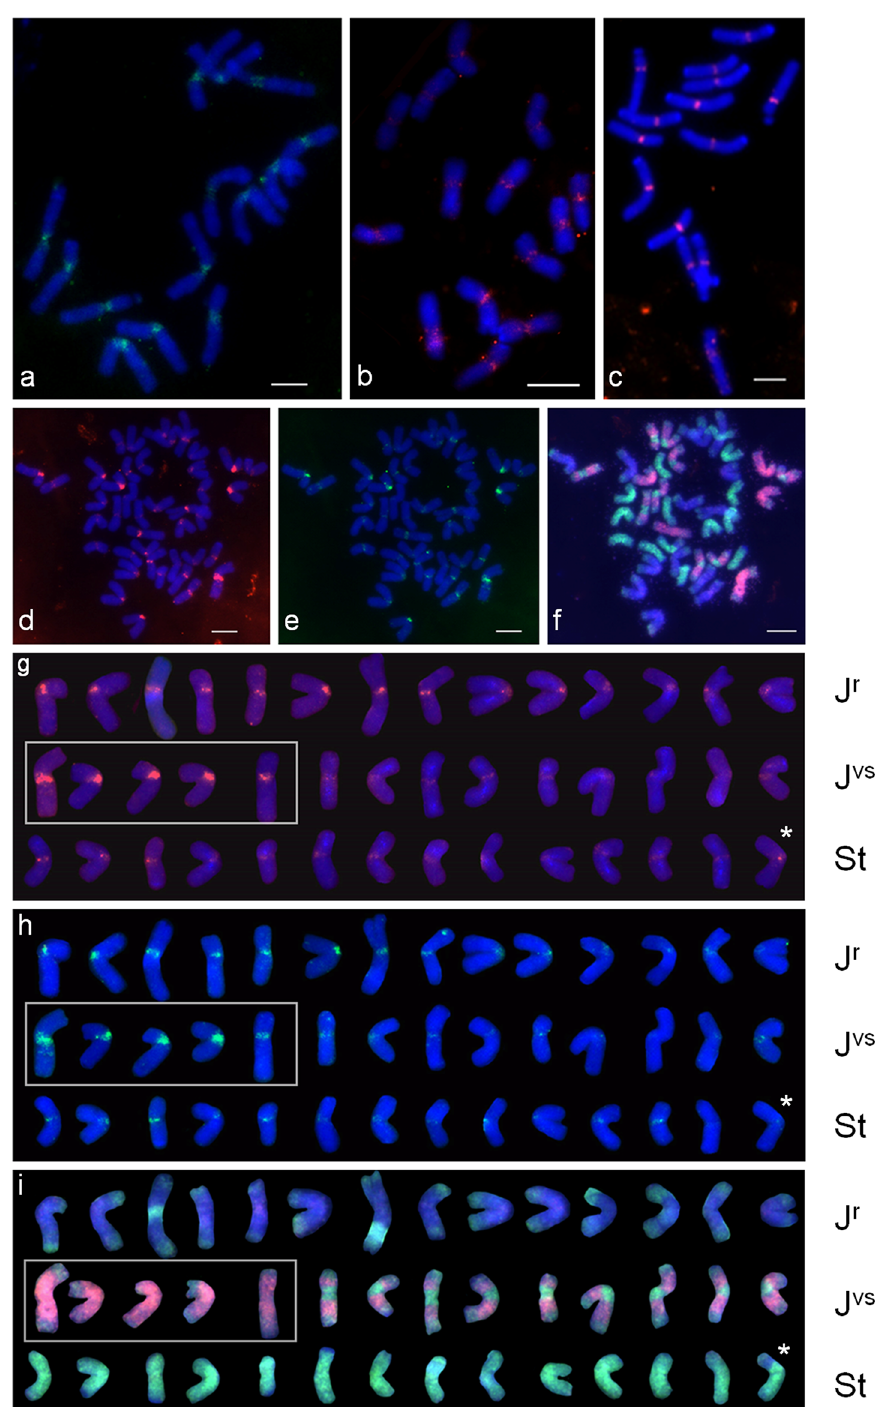
Fig 2. Hybridization of the RT-CR probes on chromosomes of D . villosum , P . spicata , Th . bessarabicum , and Th . intermedium . a-c FISH analysis using RT-CR probes onthe root-tip cells at mitotic metaphase in a) D . villosum , b) P . spicata , c) Th . bessarabicum ; the metaphase plates are probed with Davi (a, green), Pssp (b, pink) and Thbe (c, pink). Bar = 5 μ m. d-f Sequential multicolor FISH and multicolor GISH on the root-tip cells at mitotic metaphase in Th . intermedium : d) the mcFISH results using the Thbe probe (red); e) the same cell in (d) with Pssp probe (green); f) GISH analysis for the same cell in (d) and (e) with thelabeled genomic DNA of P . spicata (green) and D . villosum (pink) as probes and T . aestivum genomic DNA